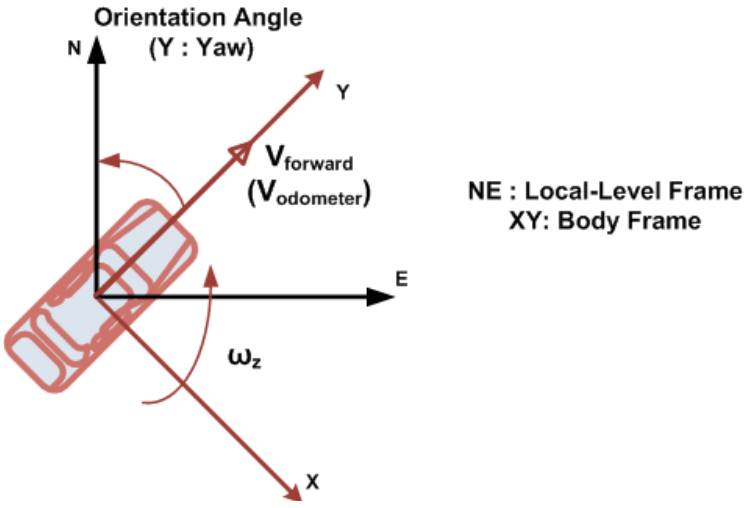
Figure 1. The RISS System Measurements in the